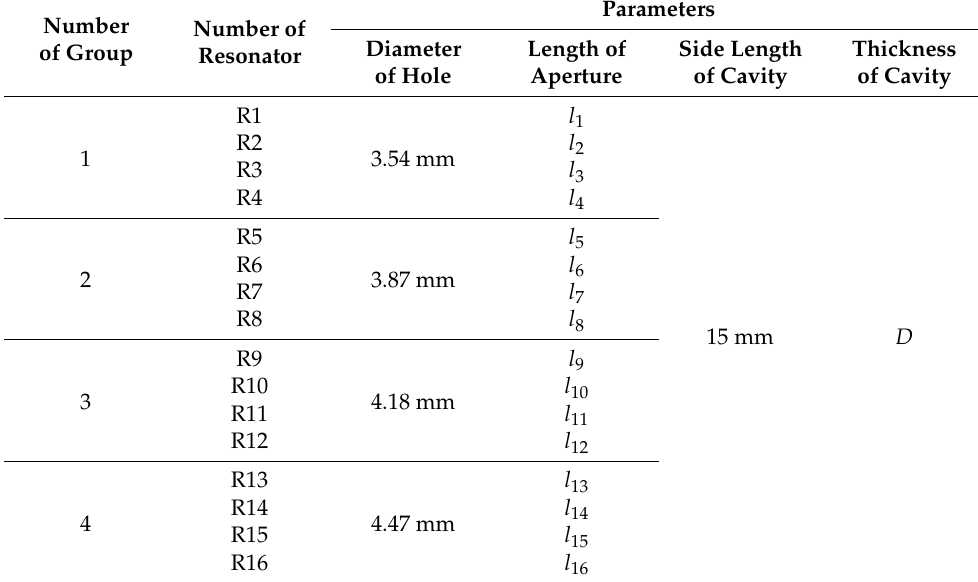
Table 1. Parameters of the metamaterial cell of the parallel–connection square Helmholtz